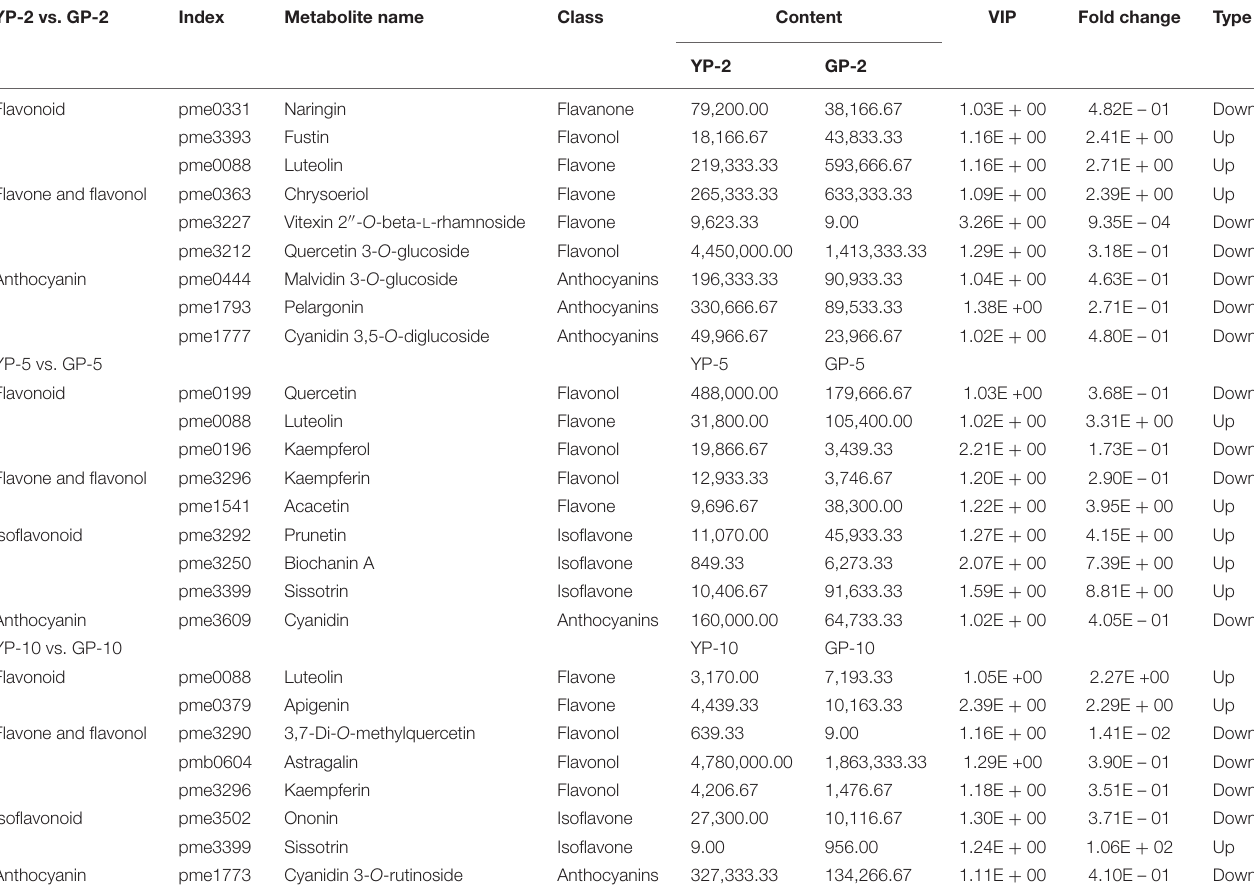
TABLE 1 | Differentially accumulated flavonoids compounds in the pod of wild type and green pod mutant. YP-2 vs.